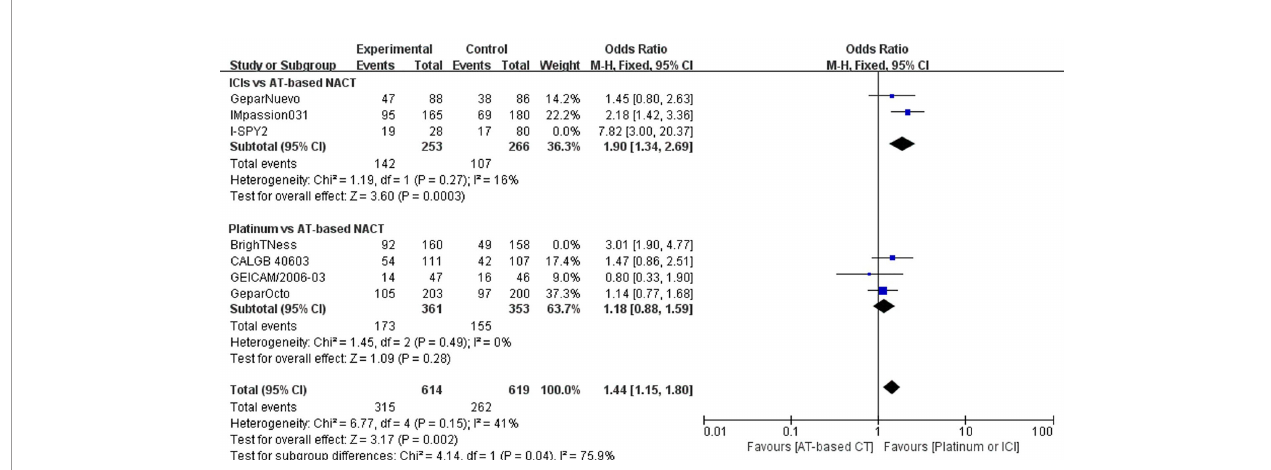
FIGURE 6 | Forest plot showing pooled OR of pCR in patients receiving ICI vs AT-based NACT excluding I-SPY2 trial and in platinum vs AT-based NACT excluding BrighTNess